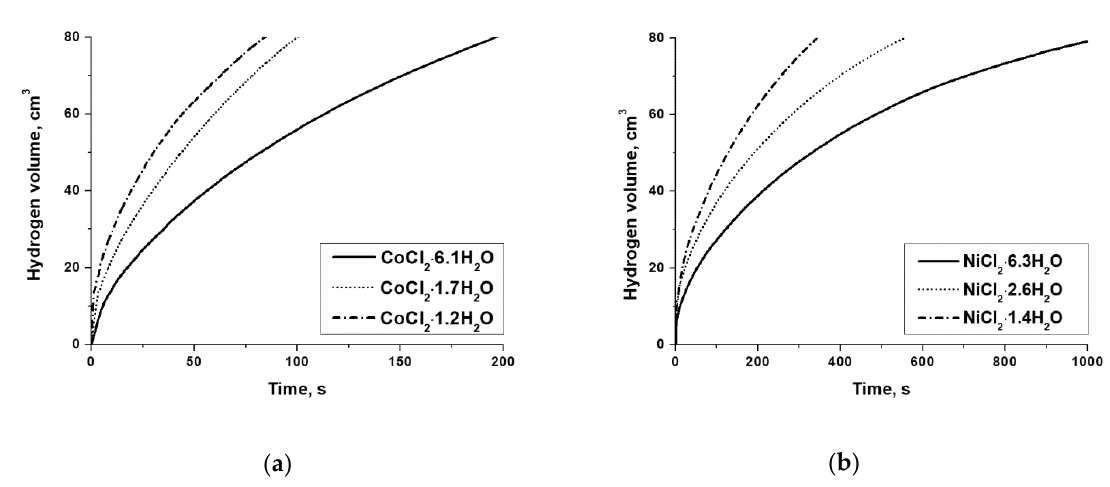
Figure 5. Effect of water content in ( a ) cobalt and ( b ) nickel chloride hydrates on the hydrogen generation from solid-state NaBH 4 compositions.